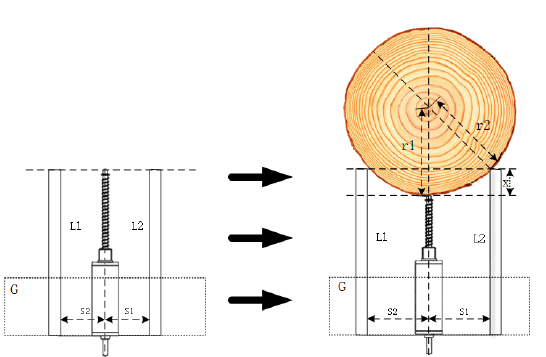
Figure 6. Schematic diagram of DBH measurement.